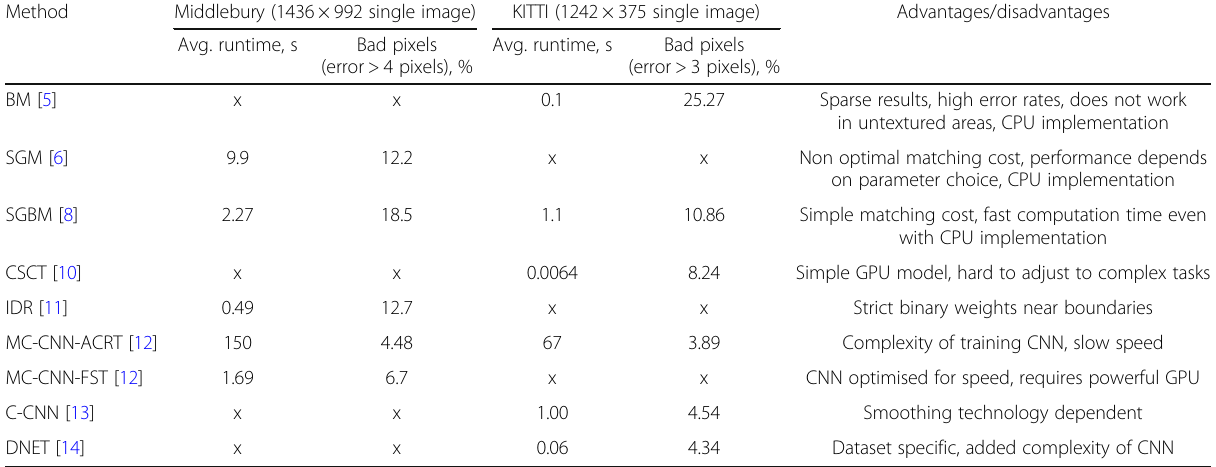
Table 1 A comparison of CUDA-based stereo matching algorithms on Middlebury and KITTI datasets Method